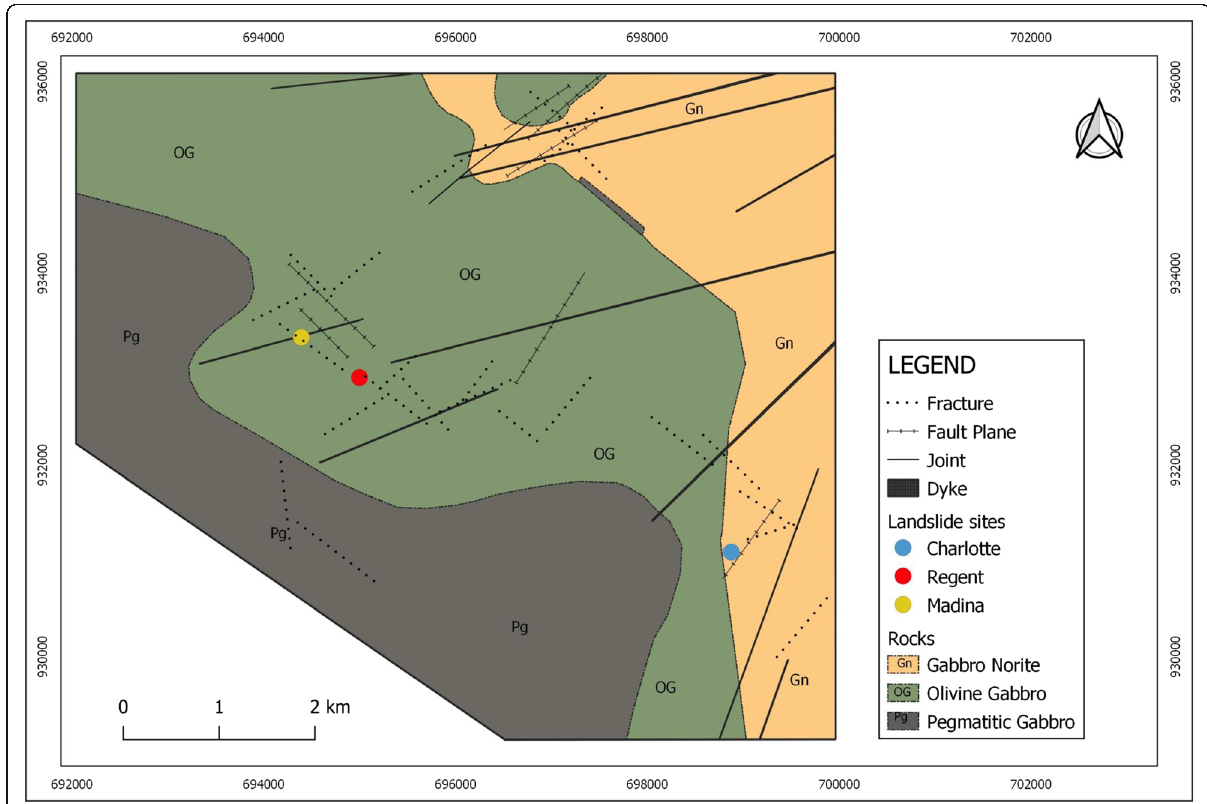
Fig. 3 Relationship between the landslides and the geology (rock types and